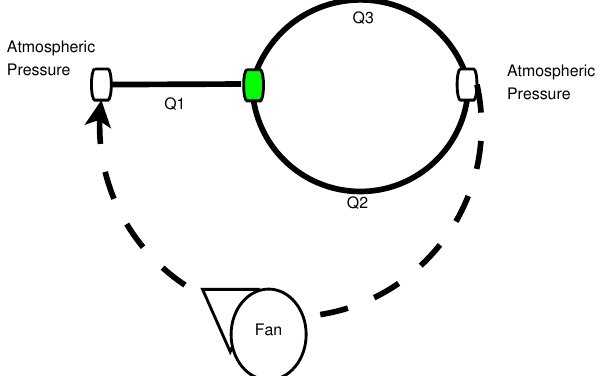
Figure 1. Small-scale ventilation system of a